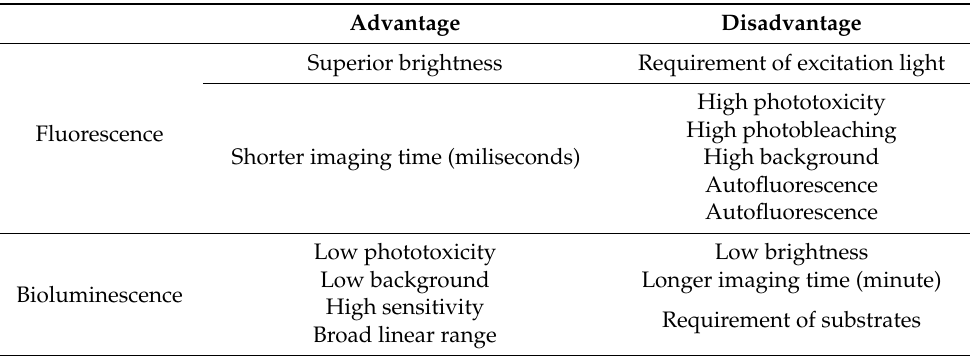
Table 1. Comparison of bioluminescence and